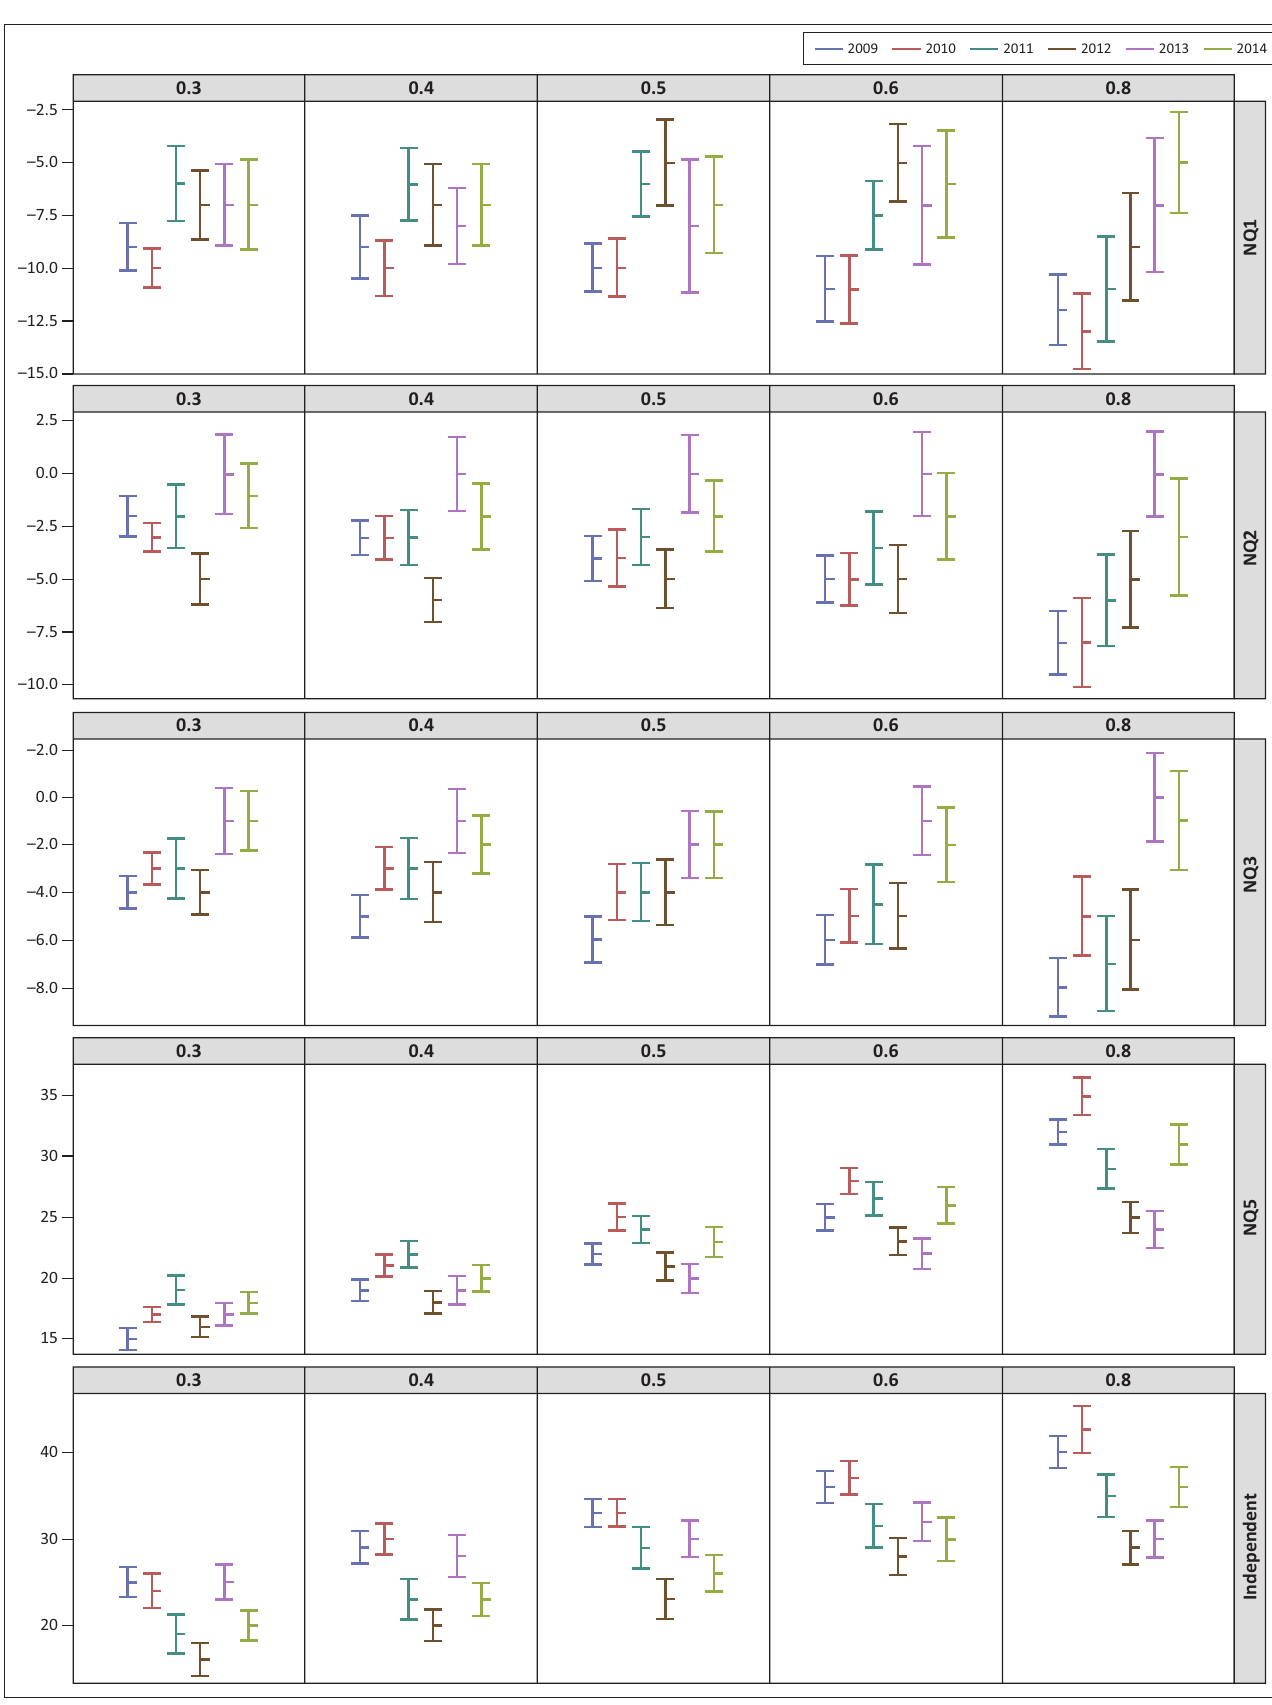
FIGURE 6: Parameter estimates and 95 % confidence limits for the school quintile types across the